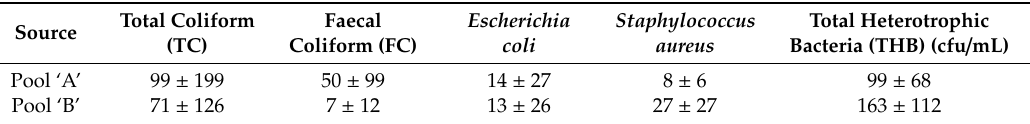
Table 4. Mean counts of bacteria observed in swimming pools ‘A’ and ‘B’ in the Tamale Metropolis from February 2014 to May